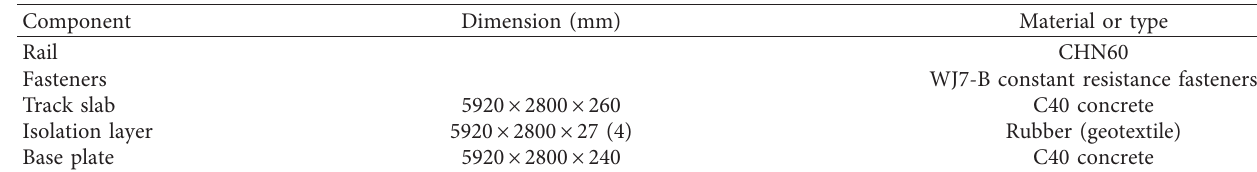
Table 1: The structural details of ballastless tracks used in this